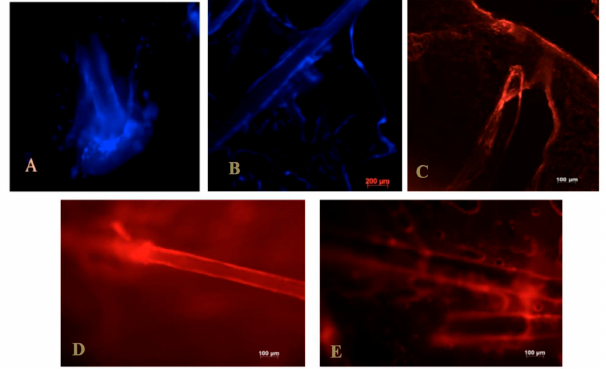
Figure 3. Fluorescence image of adapalene and Nile red localization within the hair follicles and epidermis. Fluorescent images taken from ( A ) the surface, ( B ) vertical section of porcine ear skin treated with adapalene-TyroSpheres, and ( C ) vertical section of porcine ear skin treated with Nile red-TyroSpheres. Cyanoacrylate surface biopsies of porcine ear skin treated with ( D ) Nile red-TyroSpheres, and ( E ) Nile red solution in propylene glycol. Reproduced with permission from [82], copyright 2017 Elsevier B.V.)